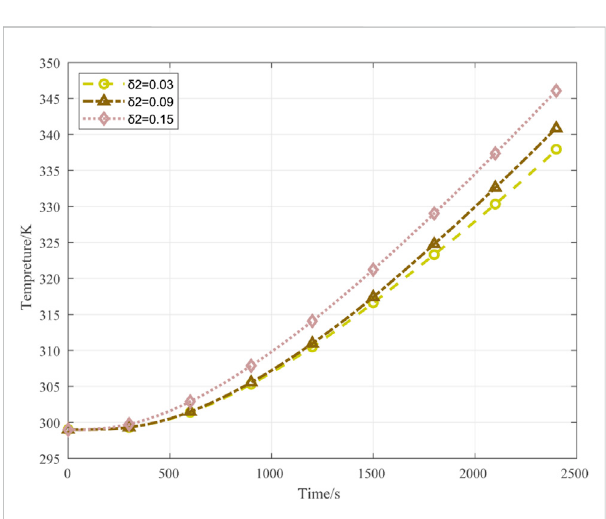
FIGURE 14 Effect of the distance δ 2 between the top of the batteries in the lowertrayandthebottomoftheuppertrayonthelowesttemperature in the drying cabinet as a function of simulation